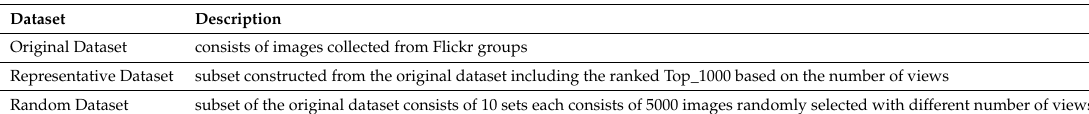
Figure 2. Examples of visually similar images. Despite the similarity, they receive a significant different number of views. Table 1. Dataset